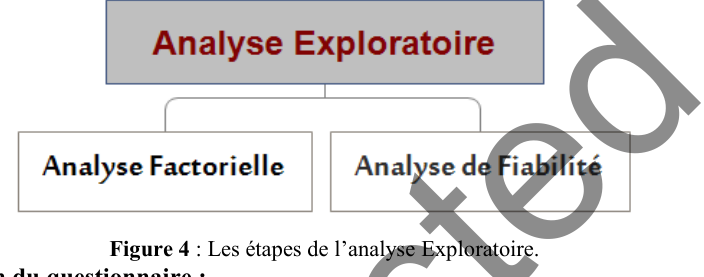
Figure 4 : Les étapes de l’analyse